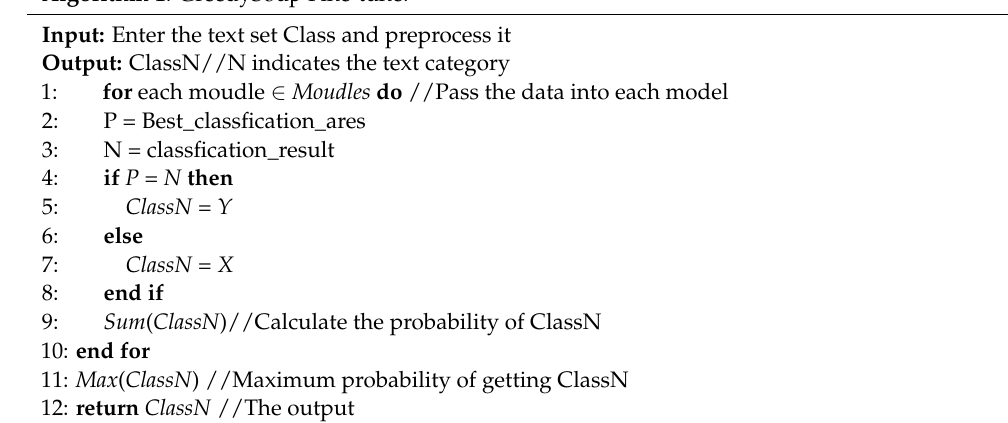
Algorithm 1 . GreedySoup